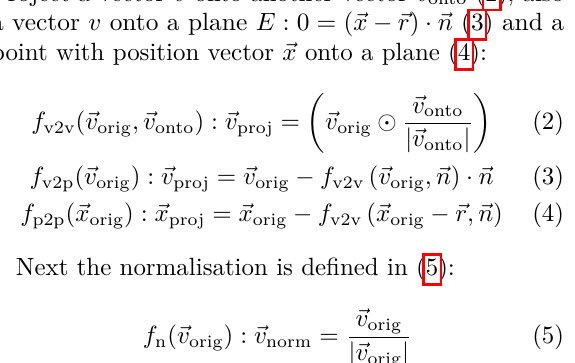
Figure 5. Logarithmic distance scaling for image size reduction